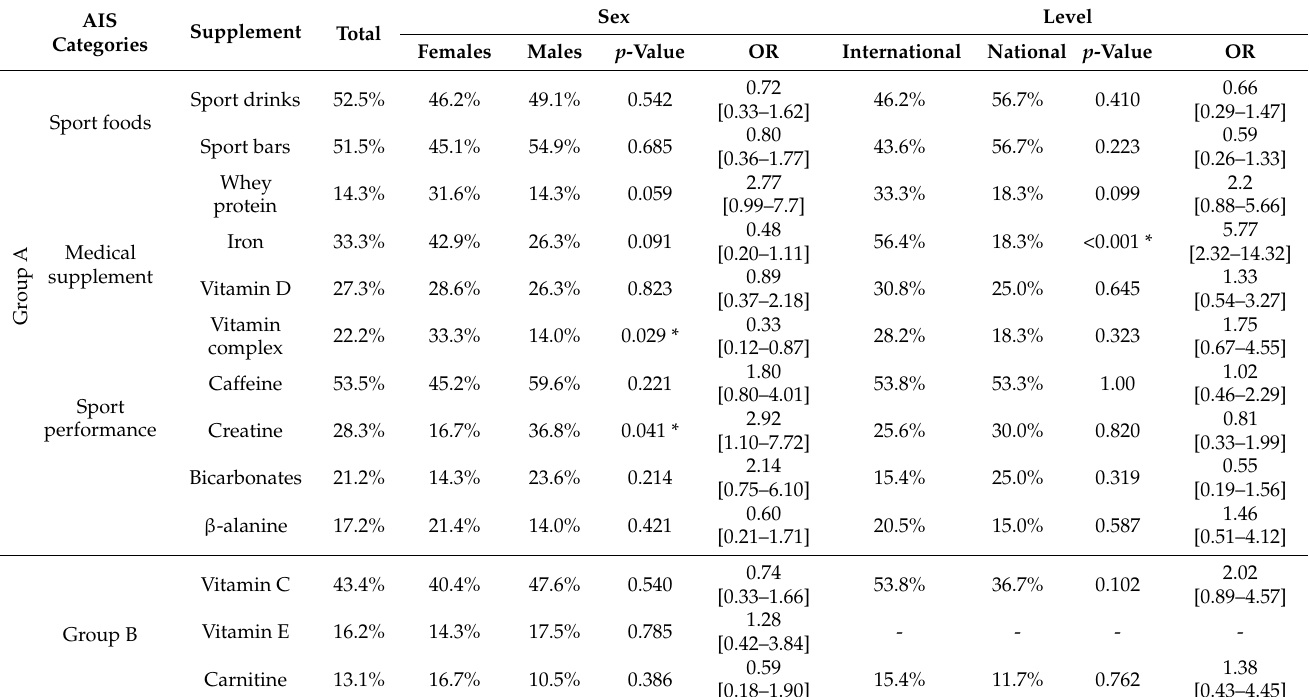
Table 3. Most used supplements according to sex and competitive level based on AIS categories